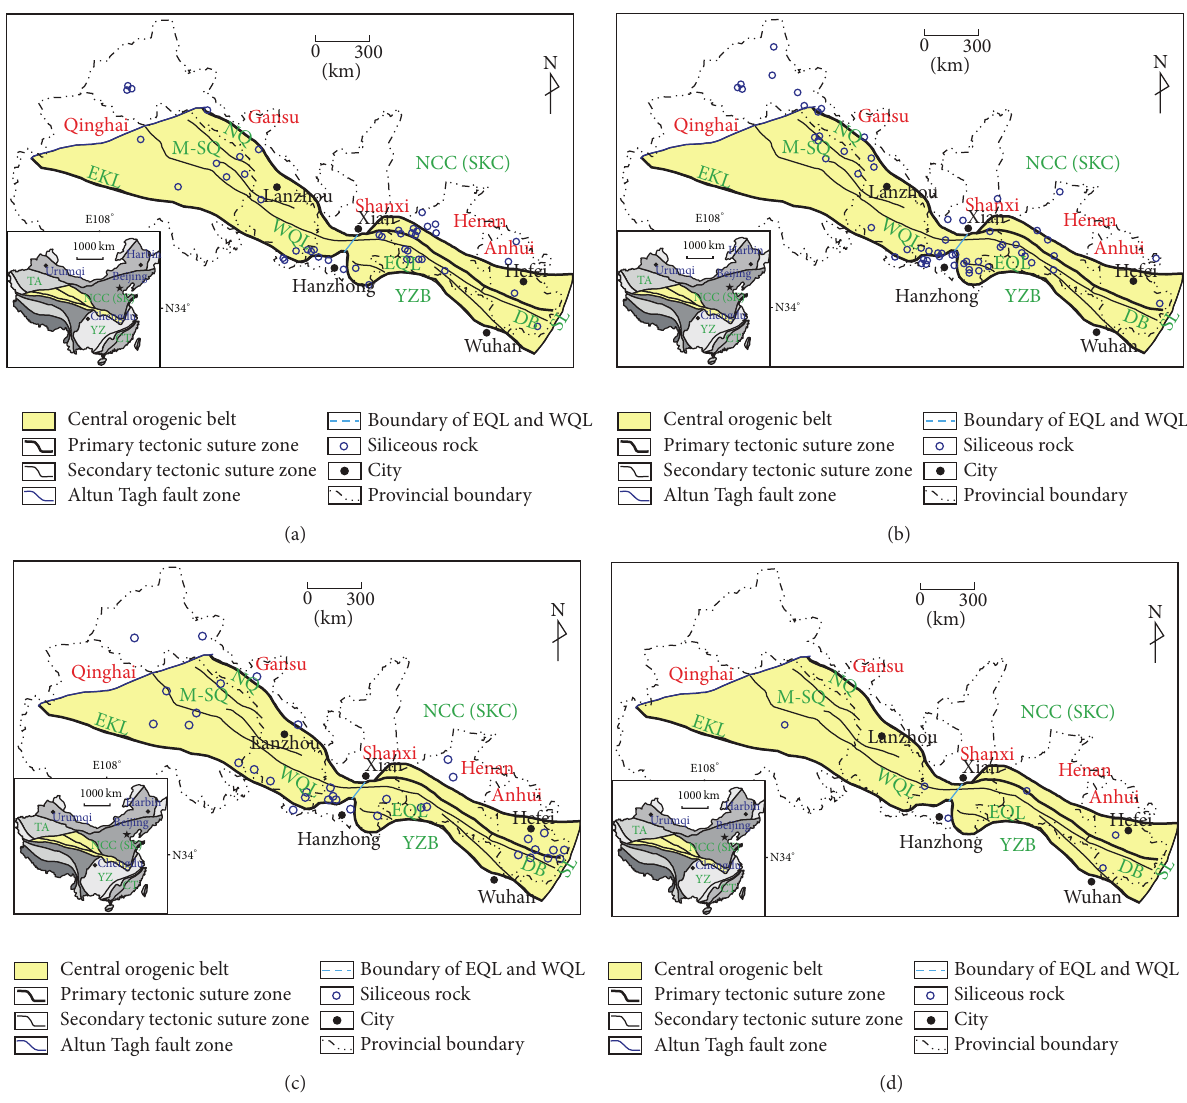
Figure 8: Distribution of siliceous rocks in central orogenic belt of China ((a): Precambrian; (b): Eopaleozoic; (c): Neopaleozoic; (d): Mesozoic; EKL: eastern Kunlun, M-SQ: Middle-South Qilian; NQ: North Qilian; WQL: Western Qinling; EQL: Eastern Qinling; SKC: Sino- Korean craton; YZB: Yangtze block; DB: Dabie orogenic belt; Data sources: [32,